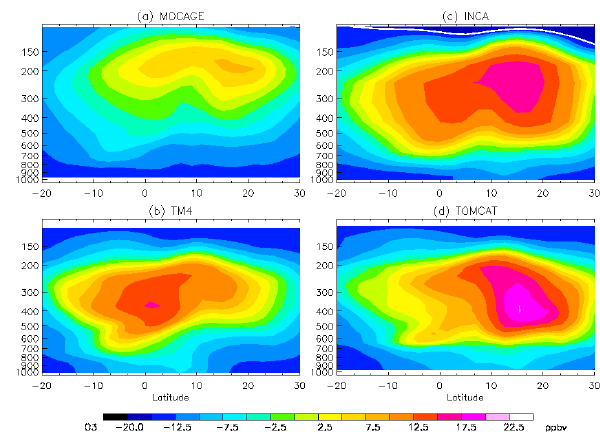
Fig. 14. August 2006 distributions of 250hPa O 3 difference be- tween Baseline and LiNO x -off simulations by (a) MOCAGE (b) TM4 (c) INCA and (d) p-TOMCAT. White contours represent the same differences but for tropospheric columns of O 3 with 1DU in- tervals from 2 to 6 DU.